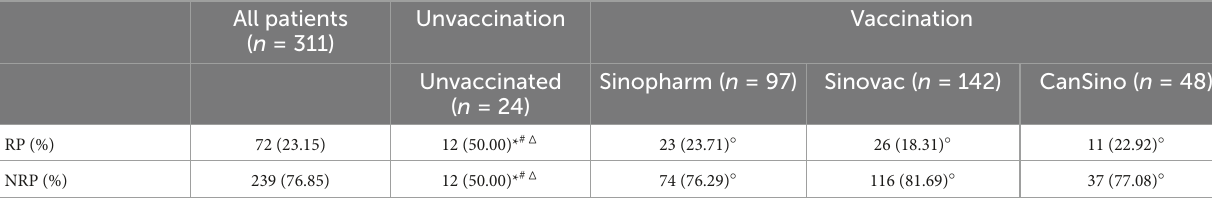
TABLE 6 The RP rate of convalescent adult patients in different groups. All patients Unvaccination ( n = 311)